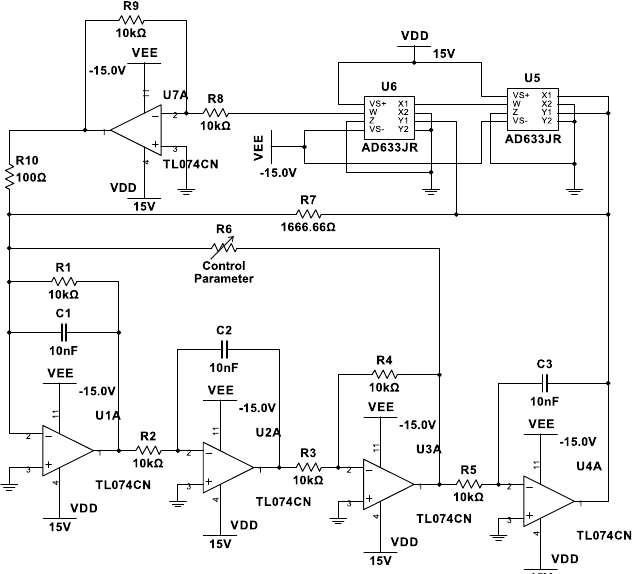
Figure 9. The circuit schematic for the proposed discrete–time map based jerk chaotic system. Using appropriate time scaling, the output voltage of U 1 A ( x 3 ) and U 3 A ( x 2 ) are directly monitored using a two-channel digital oscilloscope shown in Figure